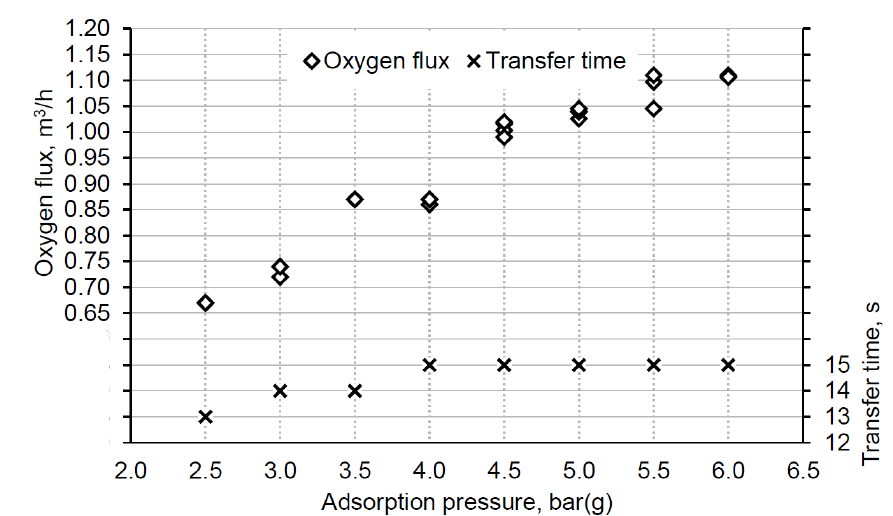
Figure 6. Optimum transfer time and maximum oxygen separation capacity depending on the adsorption pressure.